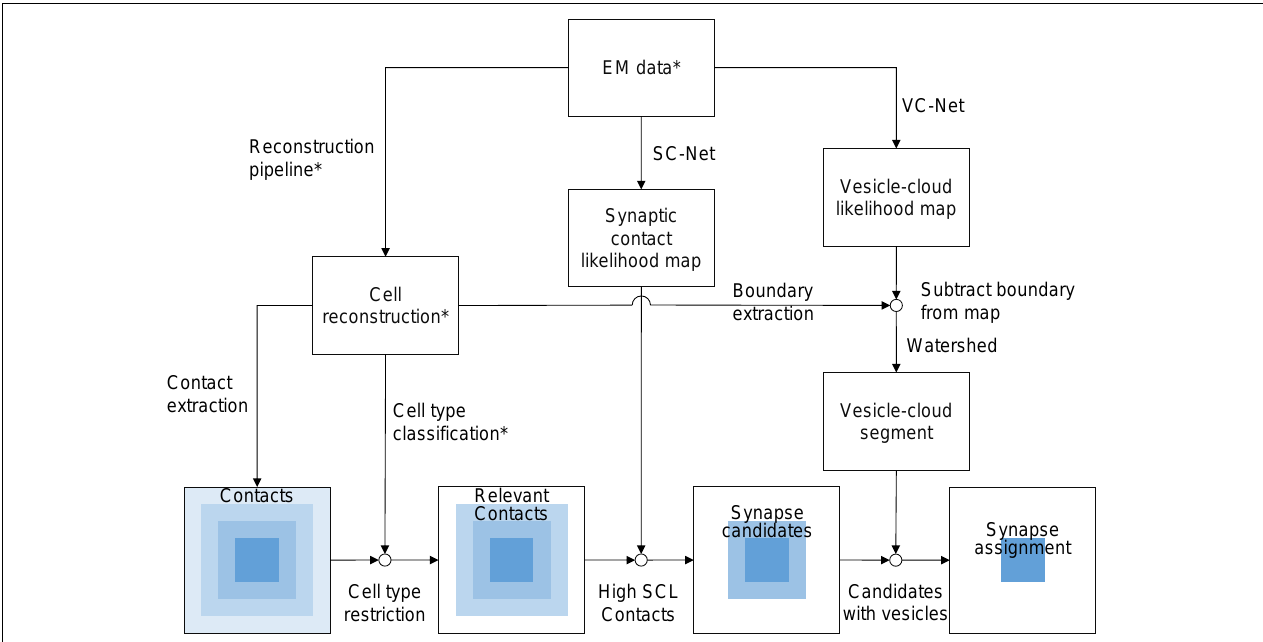
FIGURE 2 | A procedure overview of the method. The diagram showing the overall procedures of the proposed synapse detection method. The * symbols indicate the prerequisite or input data to the method. From the reconstructed neuronal fragments, the contacts between neurons are extracted. The goal of the procedures is to filter these contacts and select only the synaptic contacts (bottom row). First, the contacts are restricted by the cell types to select the relevant contacts. Second, synapse candidate contacts are selected, whose voxels have high SC likelihood values evaluated by an AI. Finally, those contacts that have a VC in a close distance are determined as the synapses, where the VC is found by another AI. At the final step, the excitatory and inhibitory synapse types and the pre- and postsynaptic neurons are assigned.